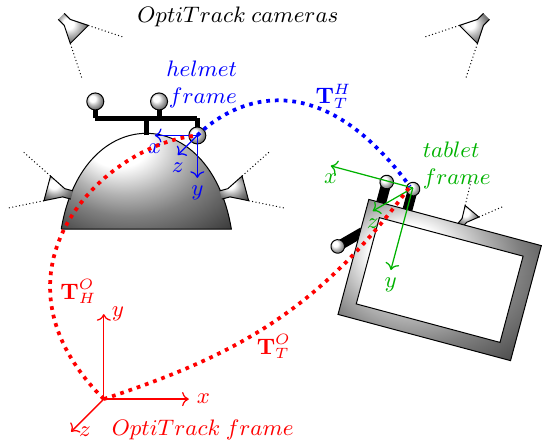
Figure 4. Evaluation scheme: the pose of the helmet system and the tablet are tracked directly with OptiTrack while the pose of the tablet is additionally derived from the helmet pose via the respective relative tracking